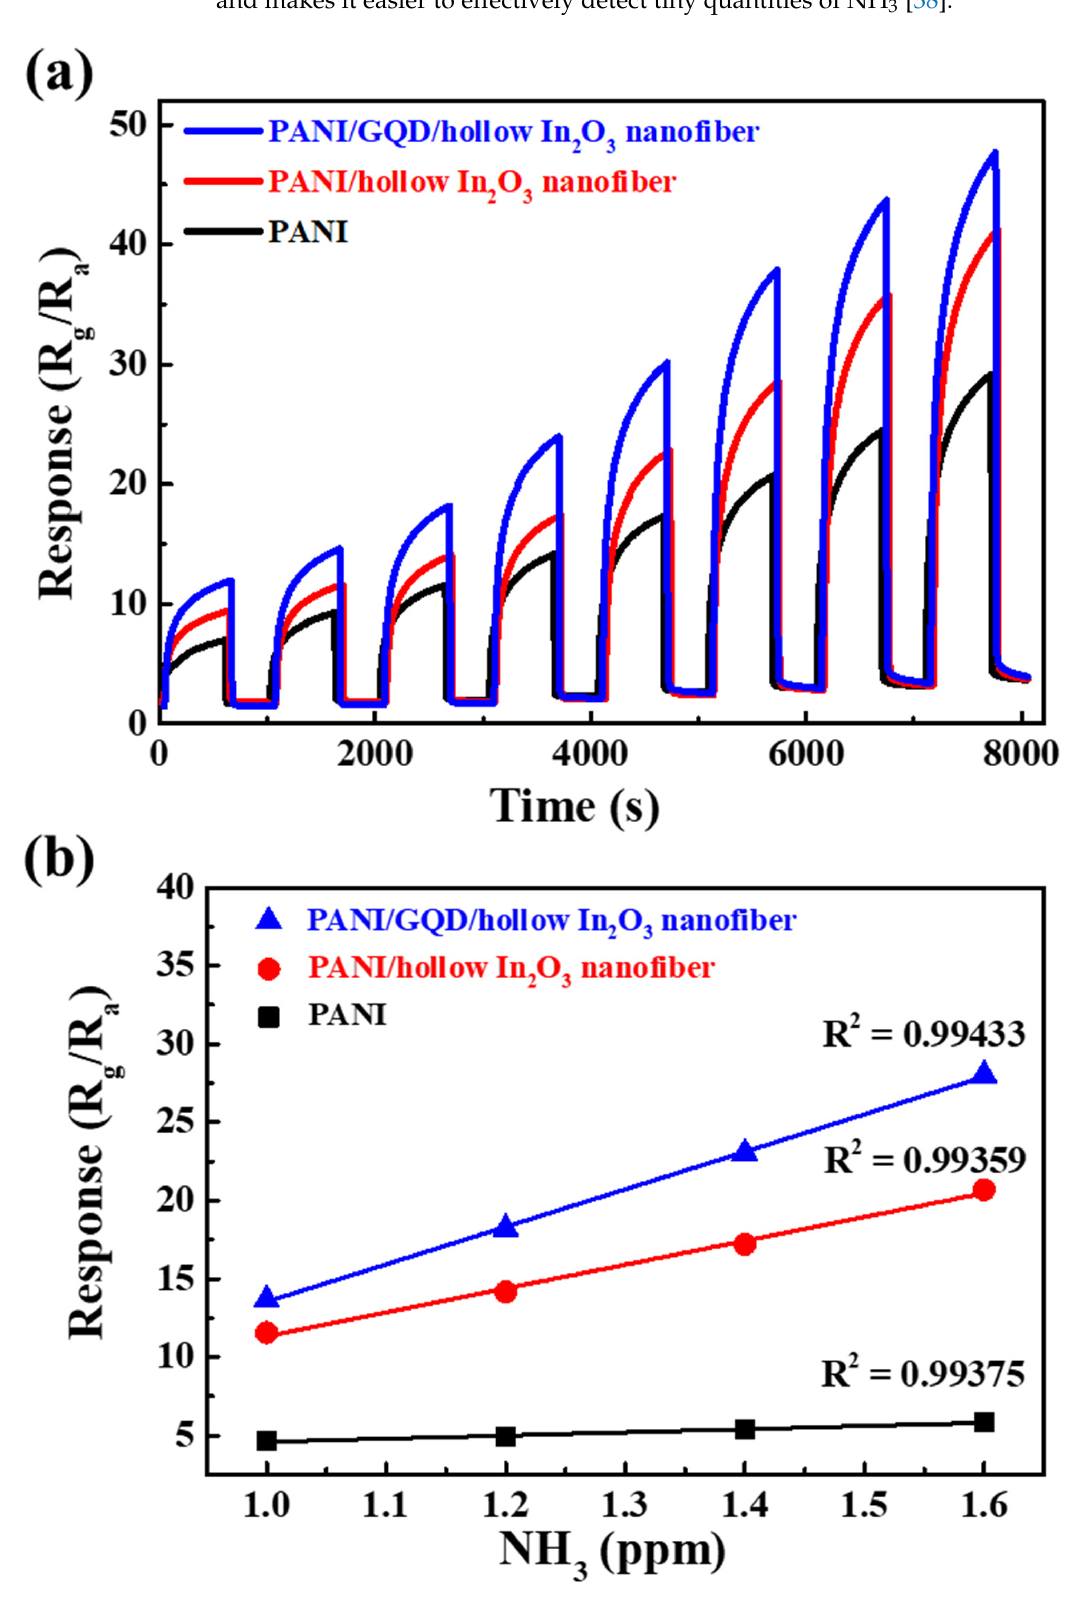
Figure 9. ( a ) Dynamic response–recovery curves and ( b ) response–concentration fitting curves of the PANI/GQD/hollow In 2 O 3 nanofiber sensor.